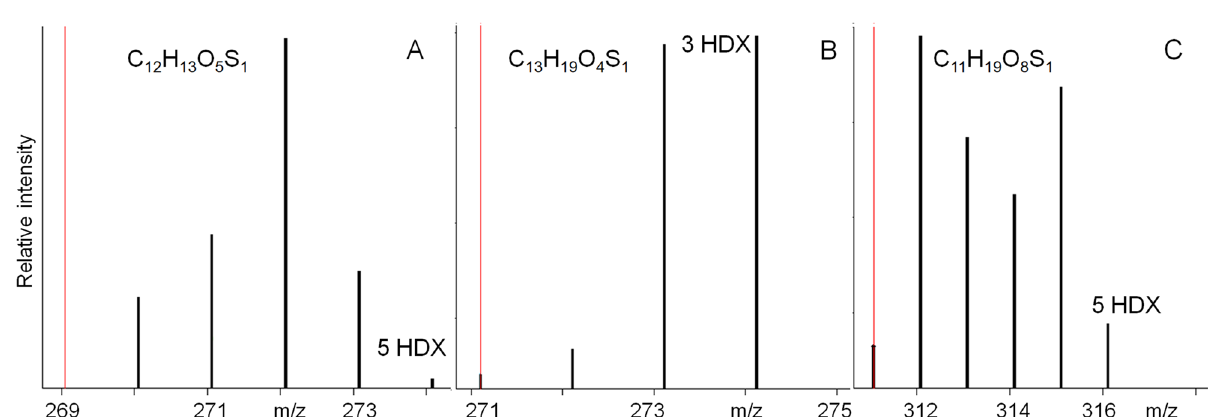
Figure 8. HDX series extracted from the full FTICR mass-spectrum of the labeled Murchison IOM sample. The red line designates m/z value of the